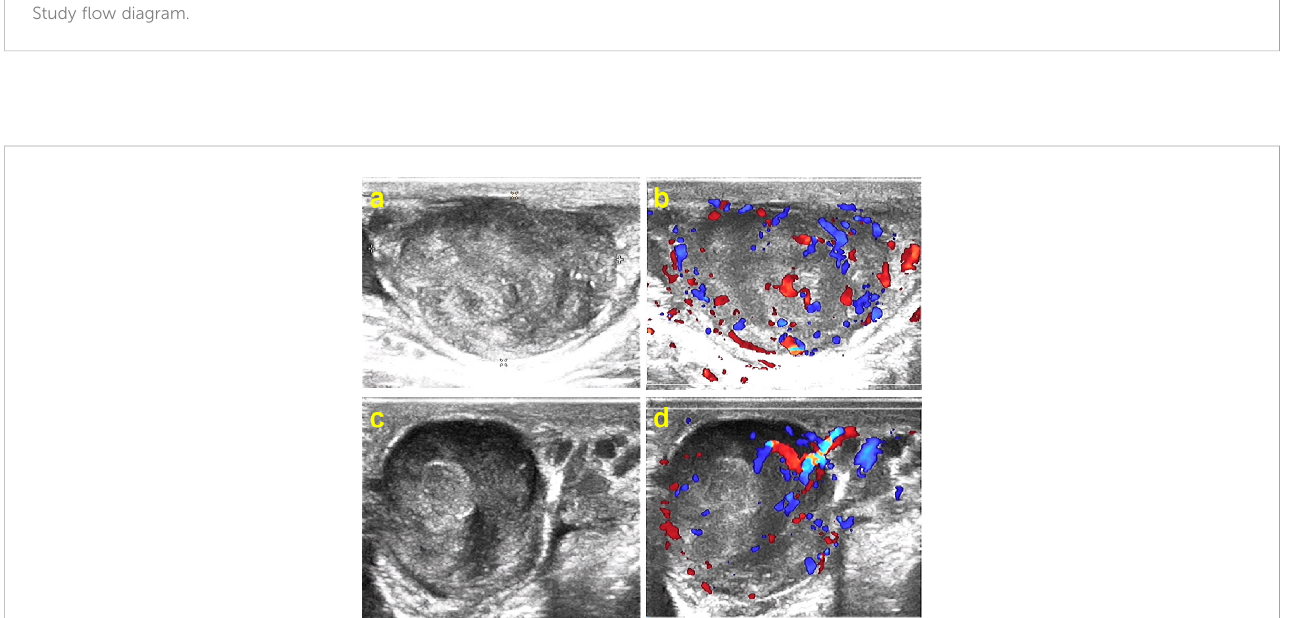
FIGURE 2 Ultrasonography of leiomyosarcoma in the caudal epididymis, (A, B) longitudinal scan, (C, D) transverse scan. There is a solid hypoechoic mass with heterogeneous internal echogenicity, clear boundaries, and abundant blood fl ow